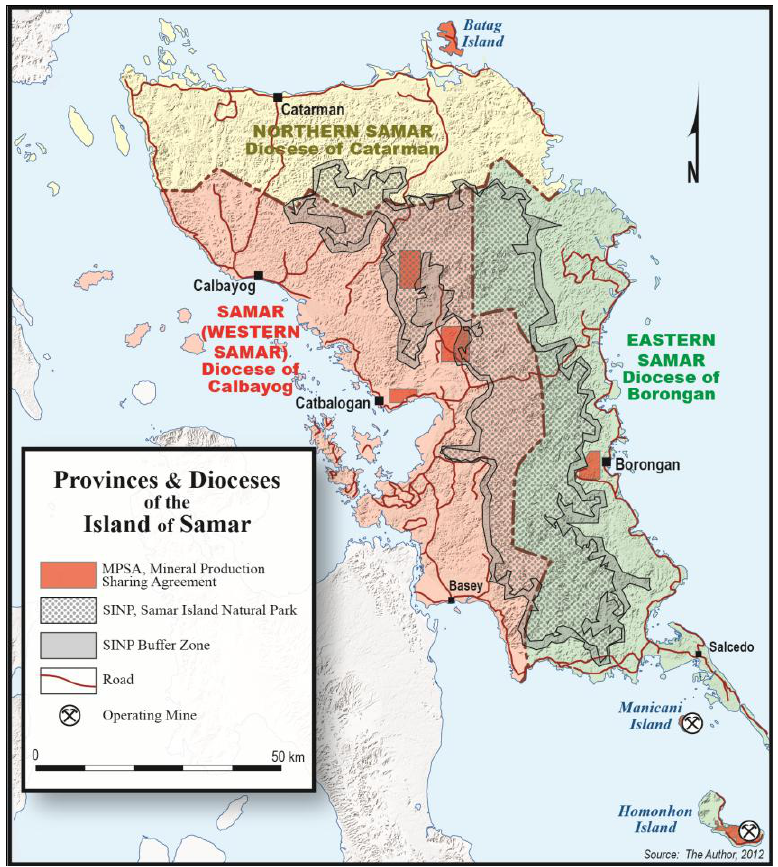
Figure 2. Samar, the Wounded